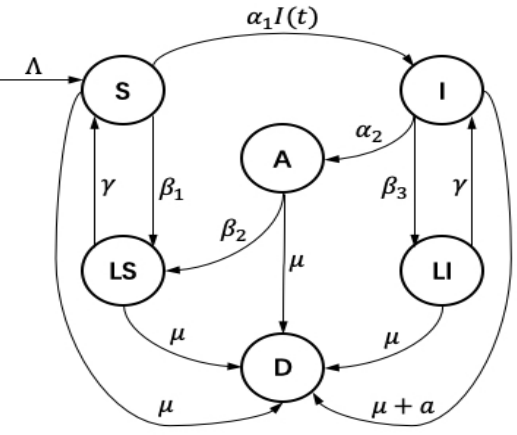
Figure 2. Flow diagram of the improved epidemic